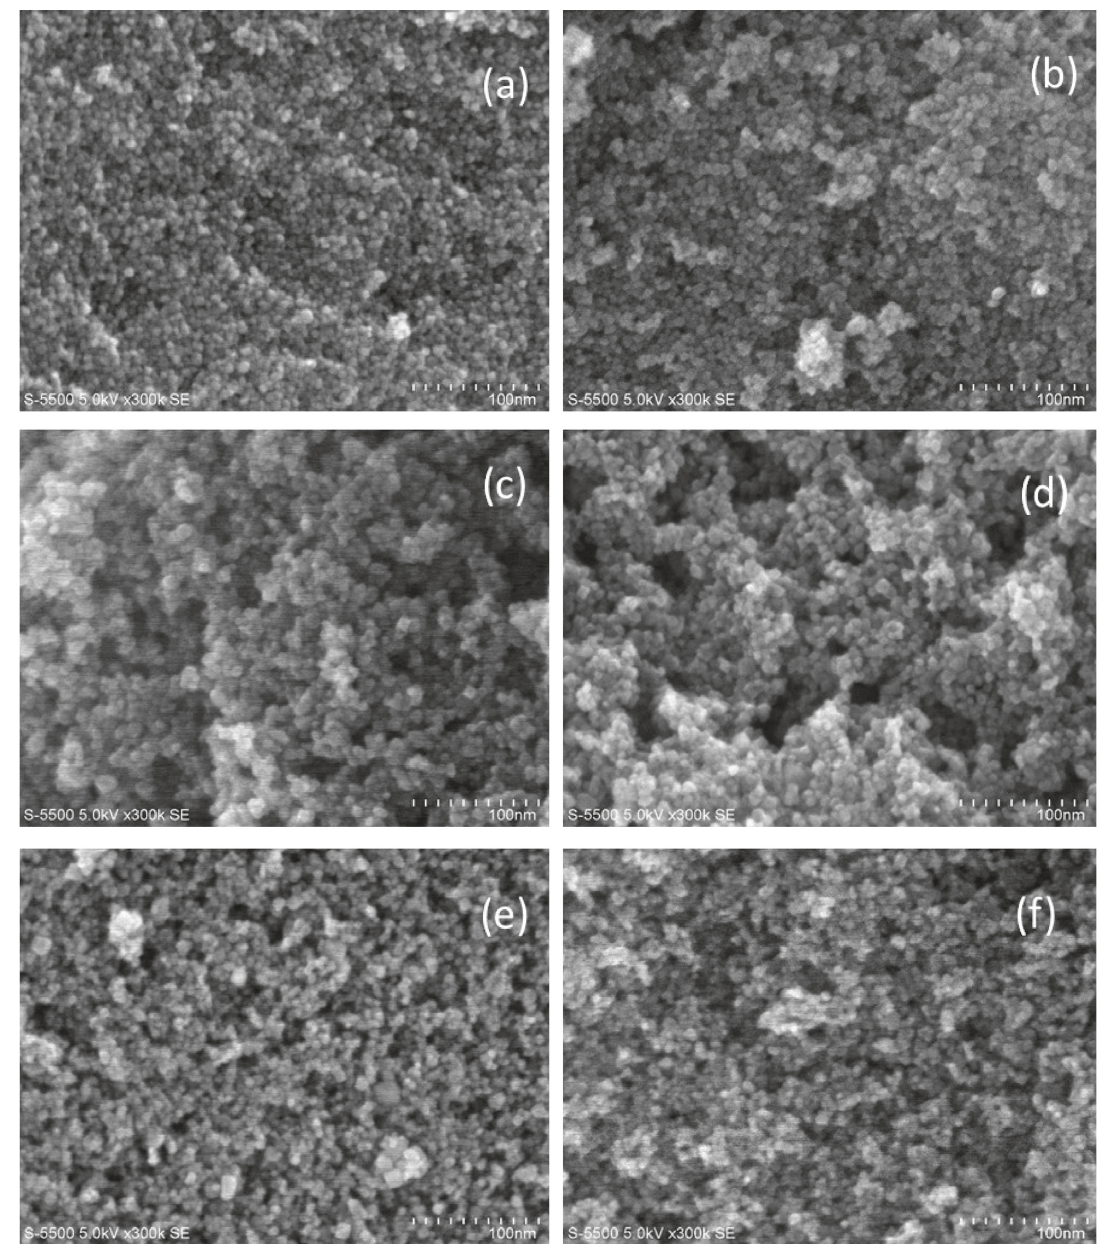
Figure 5: Micrographs (300,000X magnification) of TiO 2m synthesized at different HCl concentrations: (a) 0.5, (b) 1.0, (c) 1.5, (d) 2.0, (e) 2.5, and (f) 3.0%